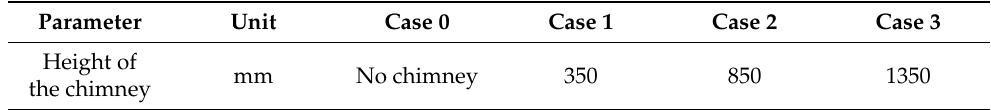
Figure 4. Tested variants of the height of the chimney; Case 0—without the chimney, Case 1—350 mm height of the chimney, Case 2—850 mm height of the chimney, and Case 3—1350 mm height of the chimney. Table 3. The heights tested for the